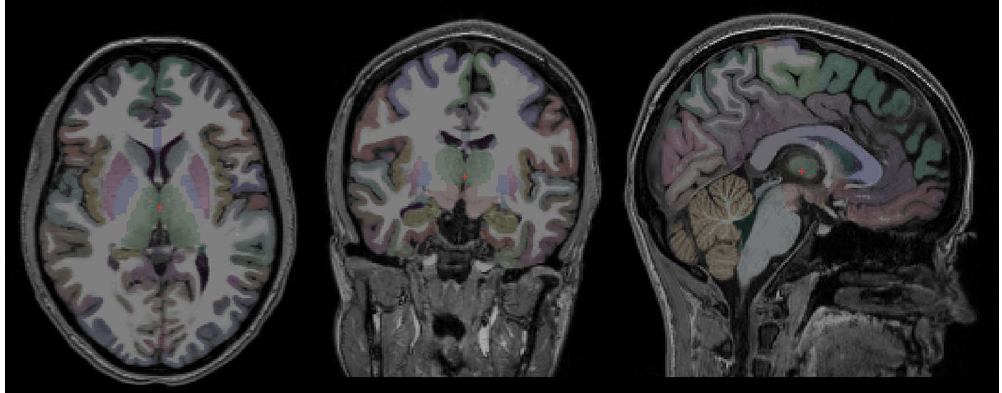
Figure 1. From left to right: axial, coronal, and sagittal representative images showing the results of automatic segmentation. All images are shown in radiologic